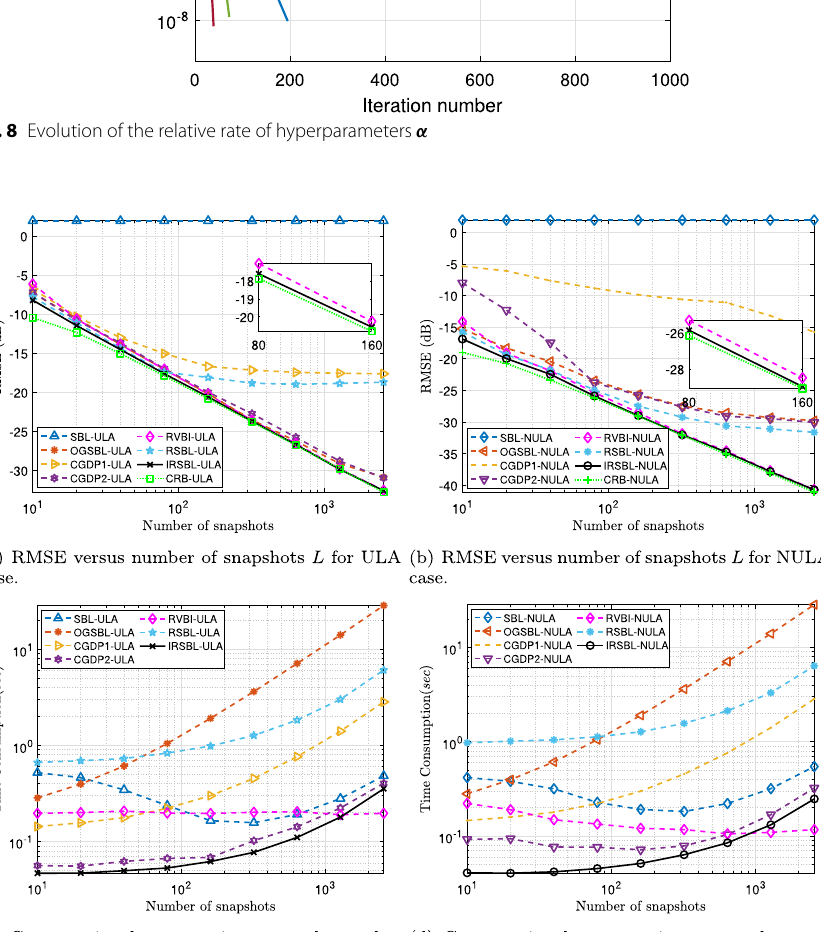
Fig. 9 Performance of SBL, OGSBL, CGDP1, CGDP2, RSBL, RVBI, and IRSBL methods versus the number of